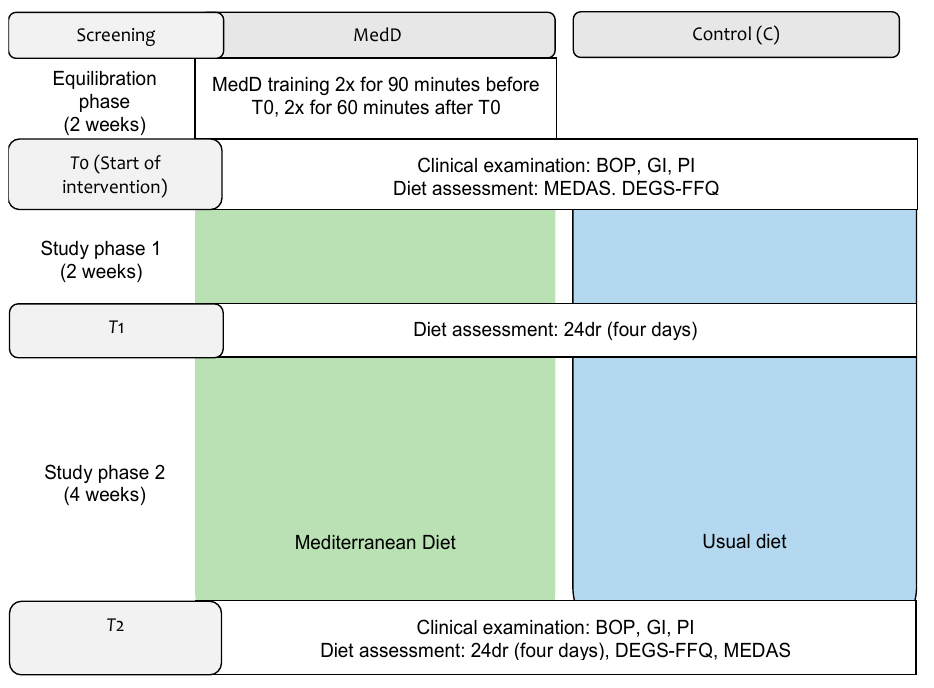
Figure 1. Study flow chart [13] PI = plaque index, GI = gingival index, BOP = bleeding on probing, PD = pocket depth, 24dr = 24-h dietary recall, FFQ = food frequency questionnaire, MEDAS = Mediter- ranean Diet Adherence